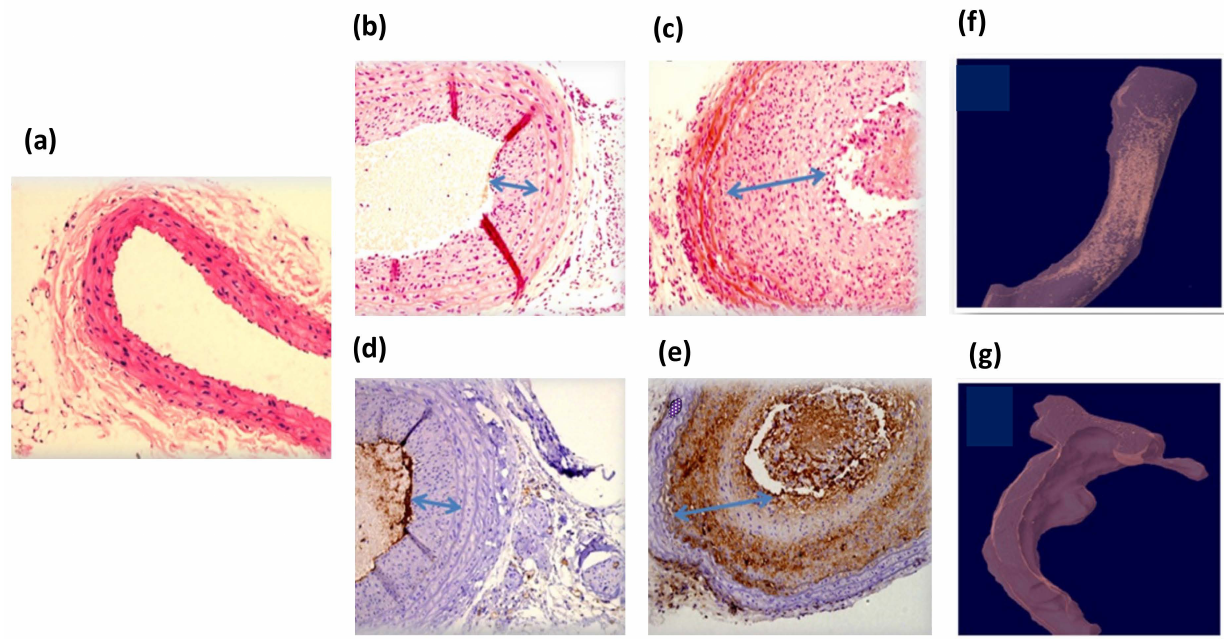
Figure 5. Ex vivo high-resolution CT scan and histology of rats’ injured arteries two weeks post GNRs injection. Panels ( a – c ): Hematoxylin and eosin (H and E) staining of normal carotid ( a ) and balloon- injured carotid artery 4 weeks post-injury and 2 weeks after GNR-HDL injection or GNRs injection ( b and c , respectively). Panels ( d , e ): CD-68 immunostaining for macrophage accumulation in the injured carotid 4 weeks post-injury and 2 weeks after GNR-HDL injection or GNRs injection ( d and e , respectively). No positive immunostaining was observed in the carotids treated with GNR-HDL, but a clear CD68 positive staining was observed in carotids treated with GNRs only. Magnifications are 40 × in panel ( a ) and 100 × in panels ( b – e ). ( f ) CT scan of the injured artery following GNRs injection. Gold is still apparent, indicating the presence of the macrophages within this artery. ( g ) CT scan of the injured artery following the GNR-HDL injection. The artery presented no GNRs accumulation, suggesting macrophage detachment from the injured